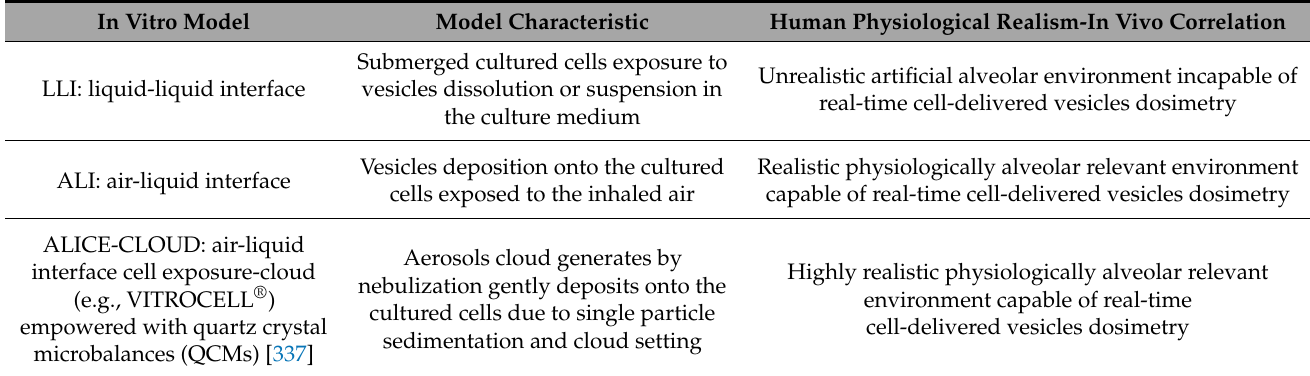
Table 3. Summary of in vitro pulmonary cell-based models for testing inhaled aerosolized mist/dried lipid bilayer